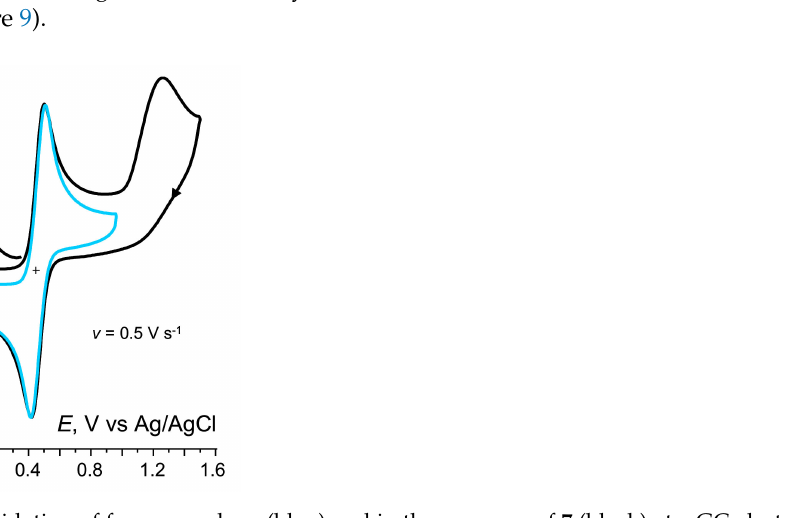
Figure 9. Oxidation of ferrocene alone (blue) and in the presence of 7 (black) at a GC electrode in AN/0.1 M Bu 4 NPF 6 . Cross marks show the E 0 s of the two redox